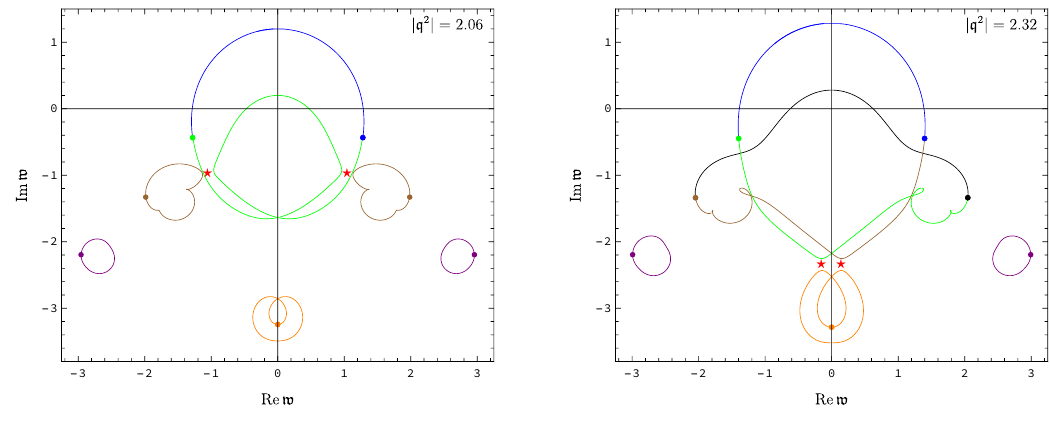
Figure 9 . Quasinormal spectrum in the sound channel at γ = 2 · 10 − 5 , computed non-perturbatively in γ . The positions of critical points are shown by red stars.